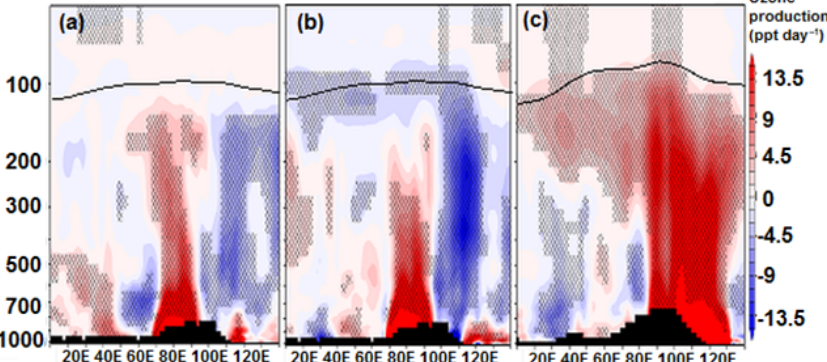
Figure 3. Longitude–pressure cross section of changes in net ozone production (pptday − 1 ) due to enhanced NO x with respect to the CTRL simulation, averaged for the monsoon season (June–September) obtained from (a) Ind38 (averaged over 8–35 ◦ N), (b) Ind73 (averaged over 8–35 ◦ N), and (c) Chin73 (over 20–45 ◦ N) simulations. The black line shows the tropopause while black hatched lines indicate 95% confidence